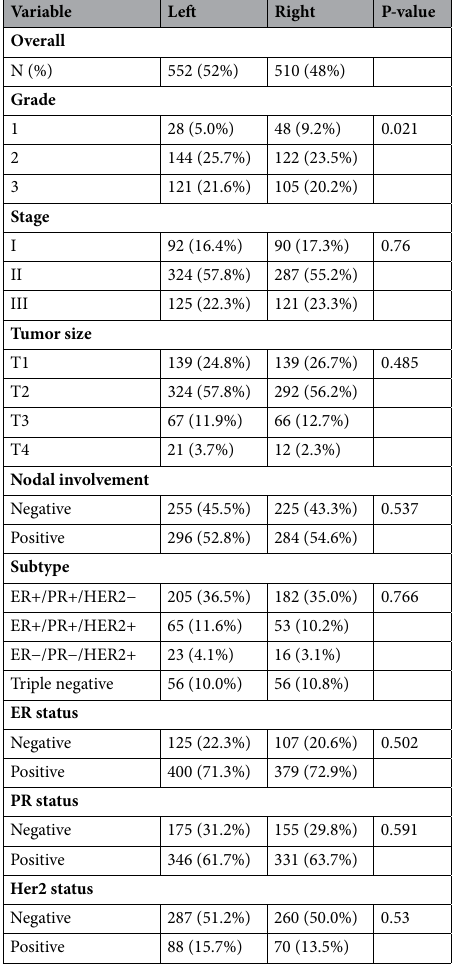
Table 2. The Cancer Genome Atlas (TCGA): baseline characteristics based on laterality. ER estrogen receptor, PR progesterone receptor, Her-2 human epidermal growth factor receptor 2.